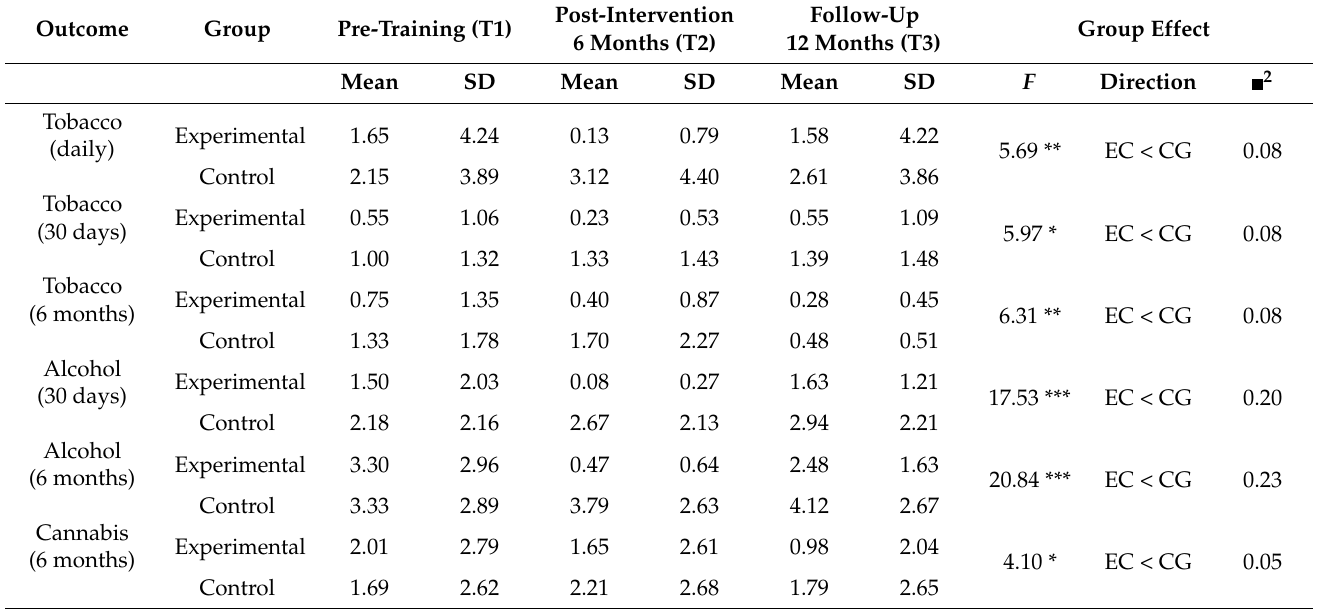
Table 3. Differences between experimental group (EG) and control group (CG) adolescents on post-intervention and